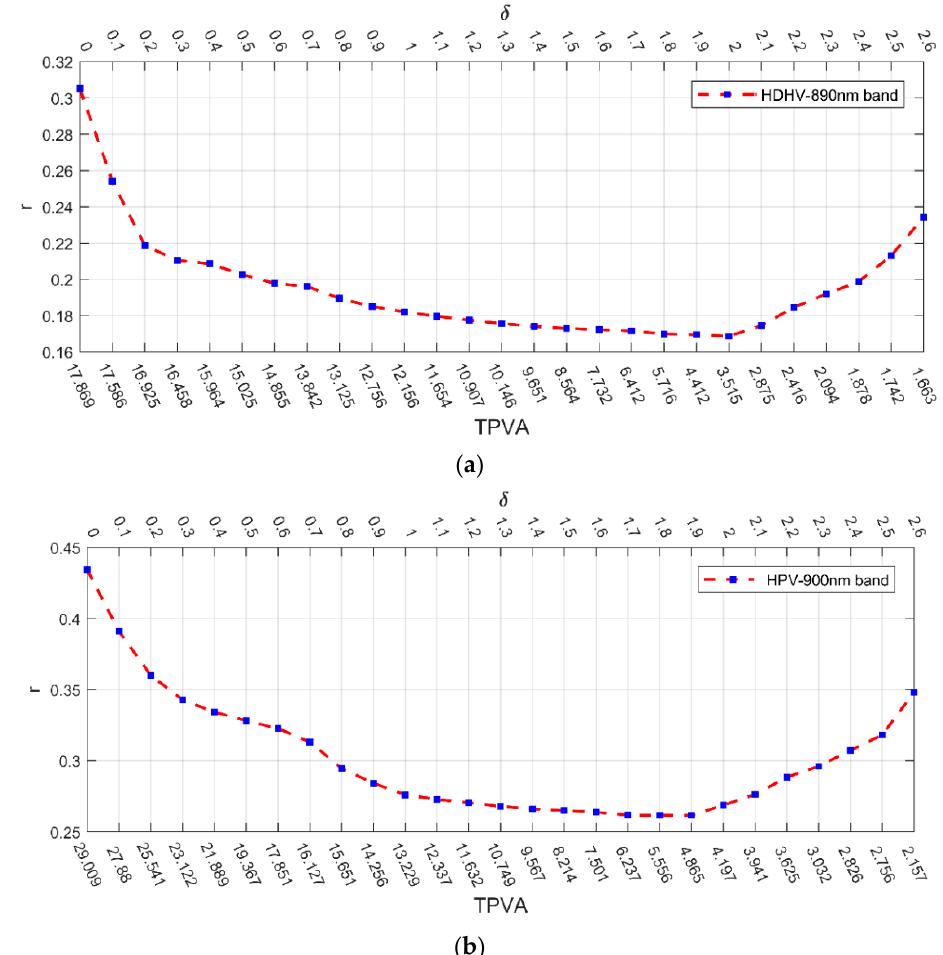
Figure 15. Discriminant proprieties with different acutance TPVA on ( a ) 890 nm band of HDHV database; ( a ) 900 nm band of HPV database. (The 𝑟 value on the 𝑦 axes is the ratio of within-class variance to between-class variance, where a smaller 𝑟 value signifies a more discriminative property). Table 2. 𝑟 values of single spectrum in optimal acutance range.